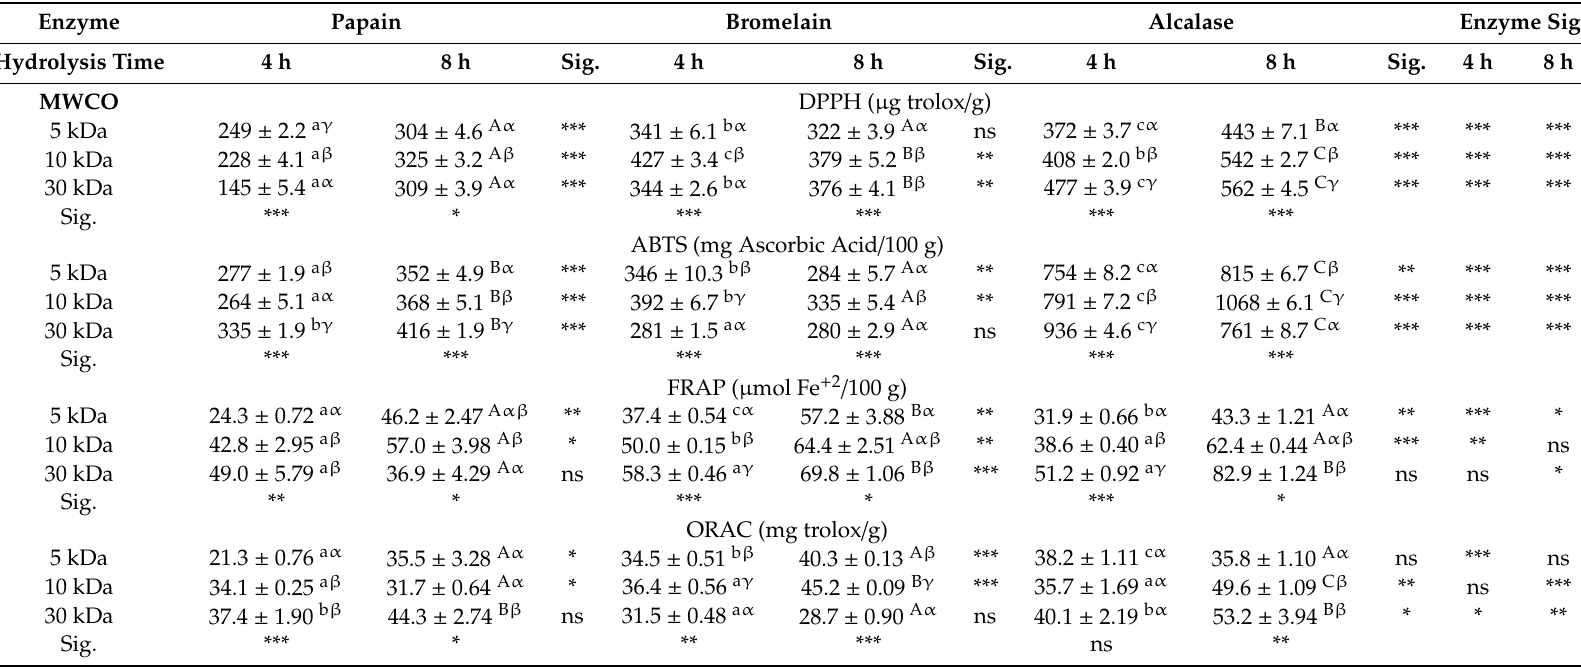
Table 2. Antioxidant activity of porcine liver protein hydrolysates obtained using alcalase, bromelain, and papain. Enzyme Papain Bromelain Alcalase Enzyme Sig. Hydrolysis Time